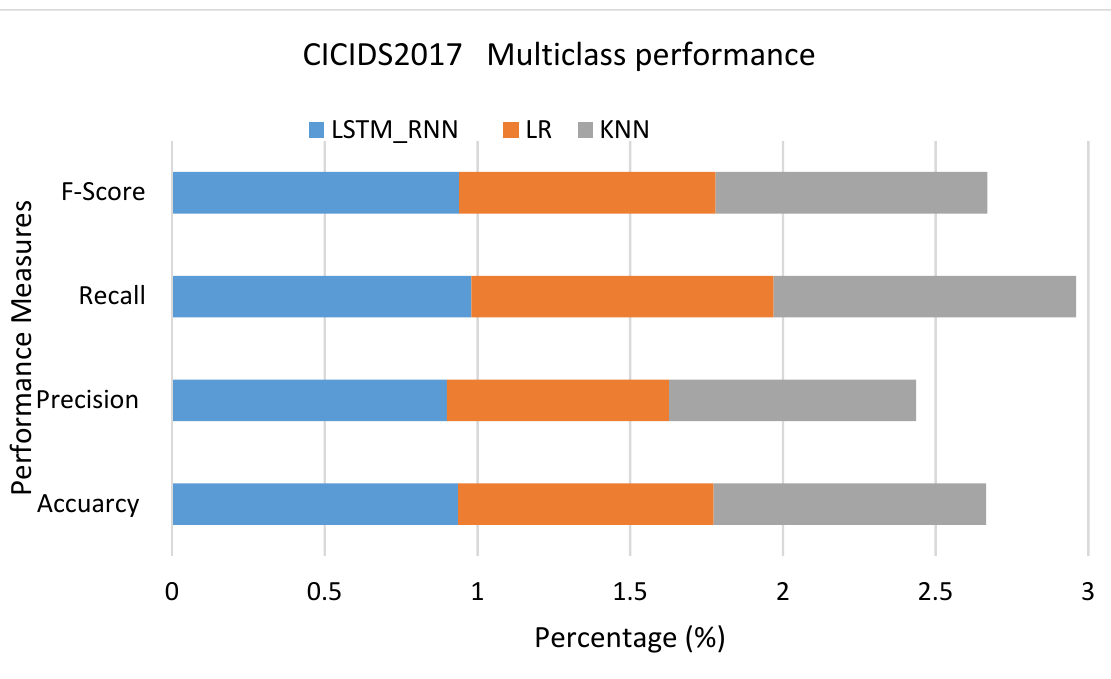
Figure 25. CICIDS2017 Multiclass classification performance comparison.